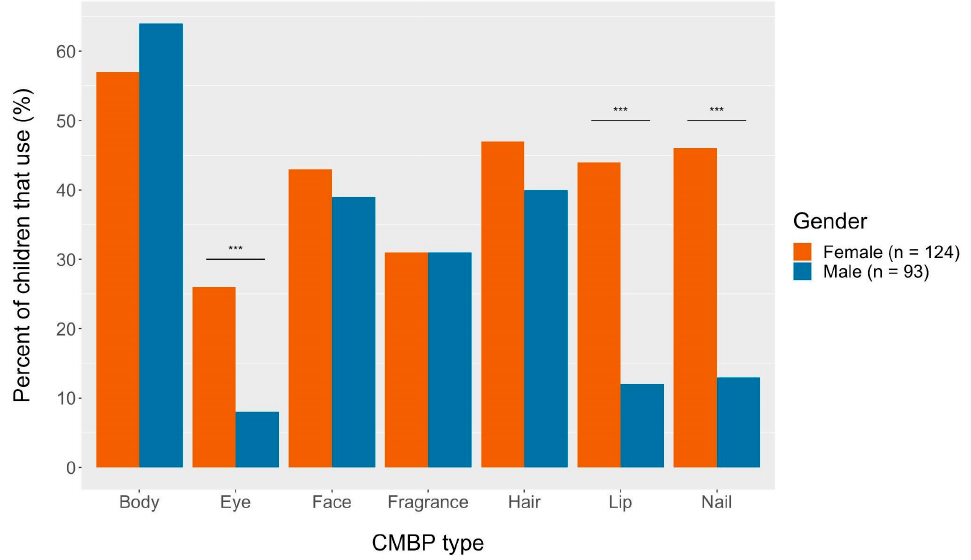
Figure 2. CMBP type by child gender. Chi-square tests conducted for each product by child gen- der. Female children include cis- and transgender female children (as do male). *** p -value < 0.0001.